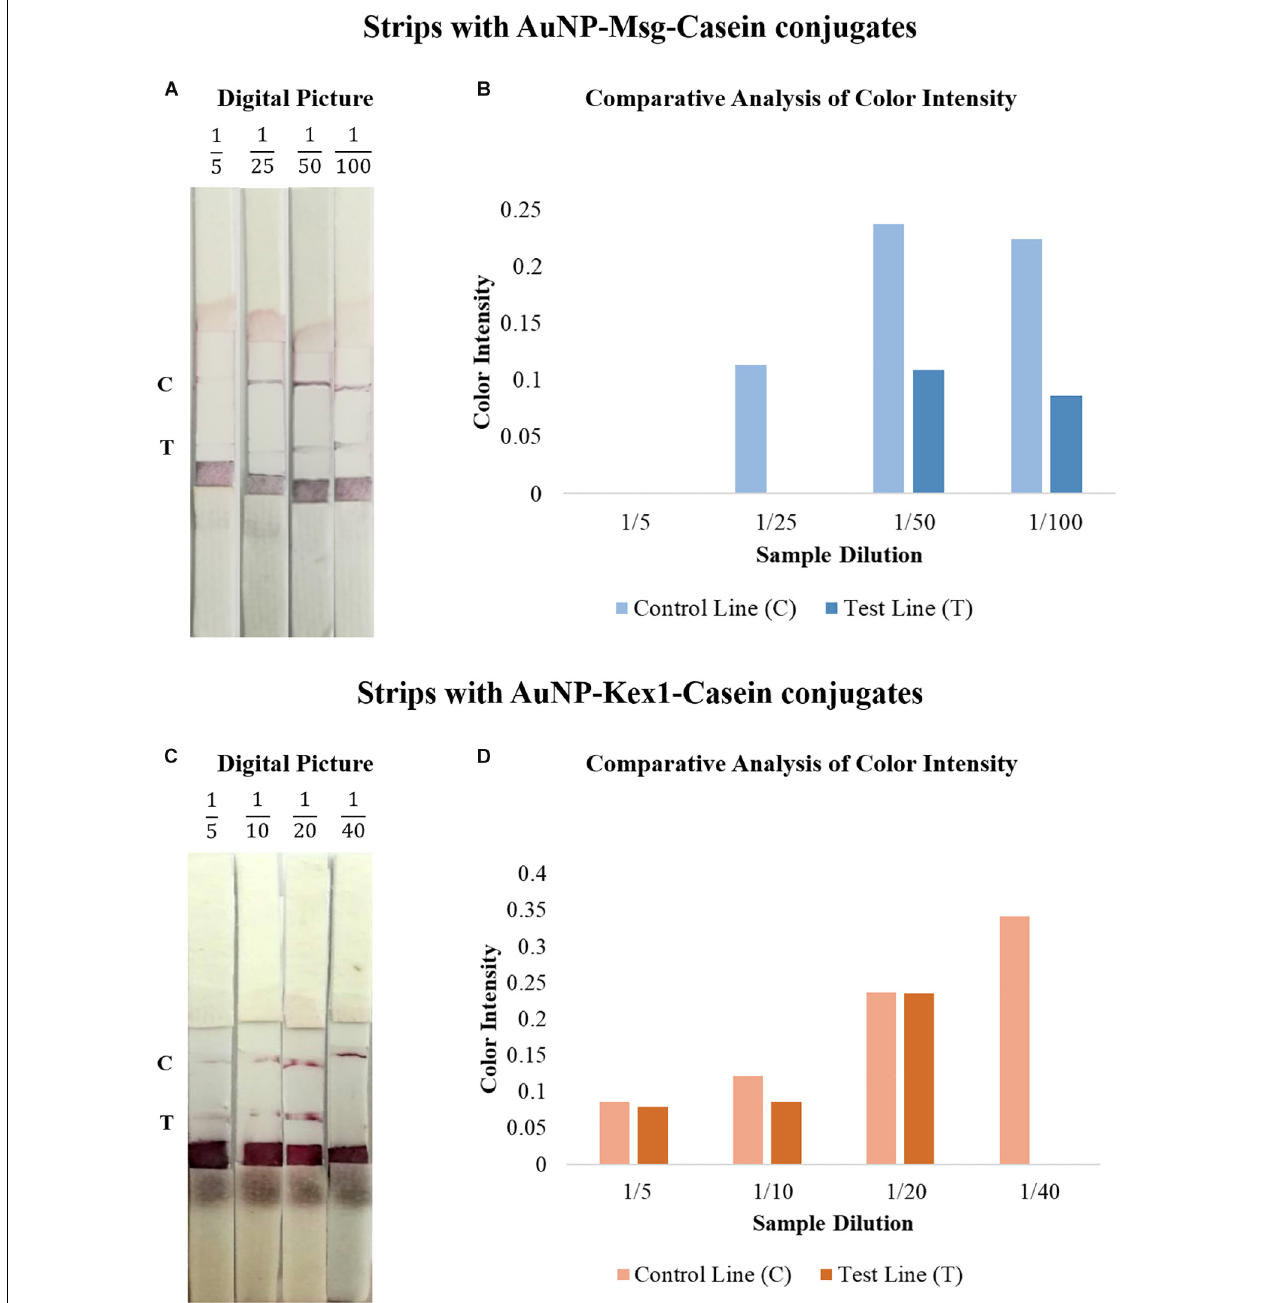
FIGURE 7 | Comparative analysis of the results from LFIA strips containing AuNP-Msg-Casein conjugates (A,B) and AuNP-Kex1-Casein conjugates (C,D) , after applying the positive sample in different dilutions. (A,C) Digital pictures of LFIA strip results with sample dilutions ranging from 1:5 to 1:100 in Msg LFIA strips and ranging from 1:5 to 1:40 in Kex1 strips. From bottom to top, strips were composed by the sample pad, the conjugate pad, the nitrocellulose membrane with the test (T) and control (C) lines and the absorbent pad. (B) Quantification of color intensity of the control and test lines, where the intensity shown in each line corresponds to the maximum height of the Gaussian line fitted by eReuss